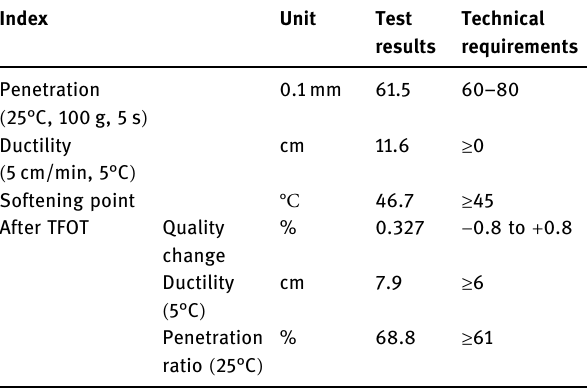
Table 1: Technical indicators of matrix